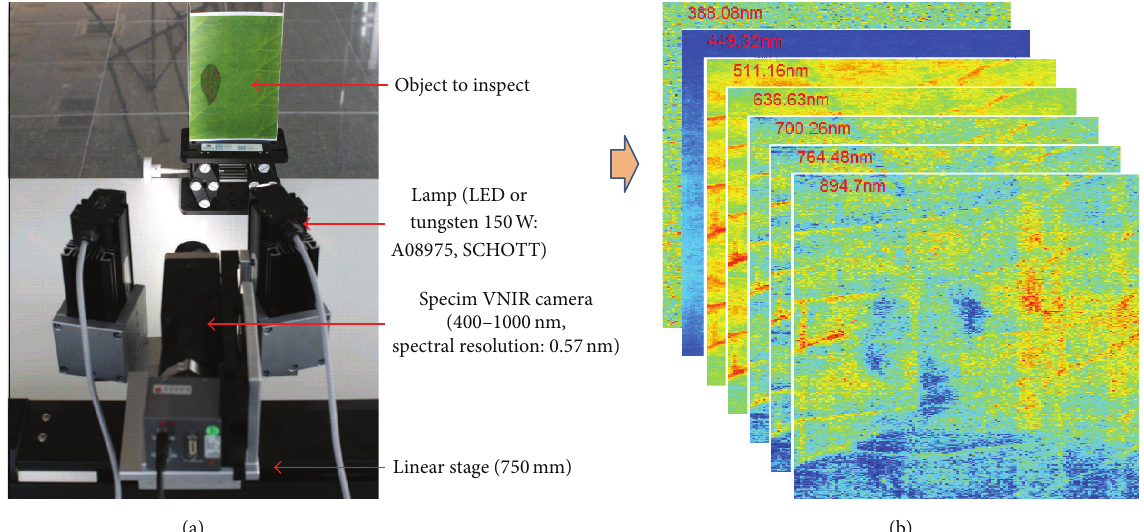
Figure 2: Hypercube: (a) VNIR hyperspectral image acquisition system and (b) sample spectral images.